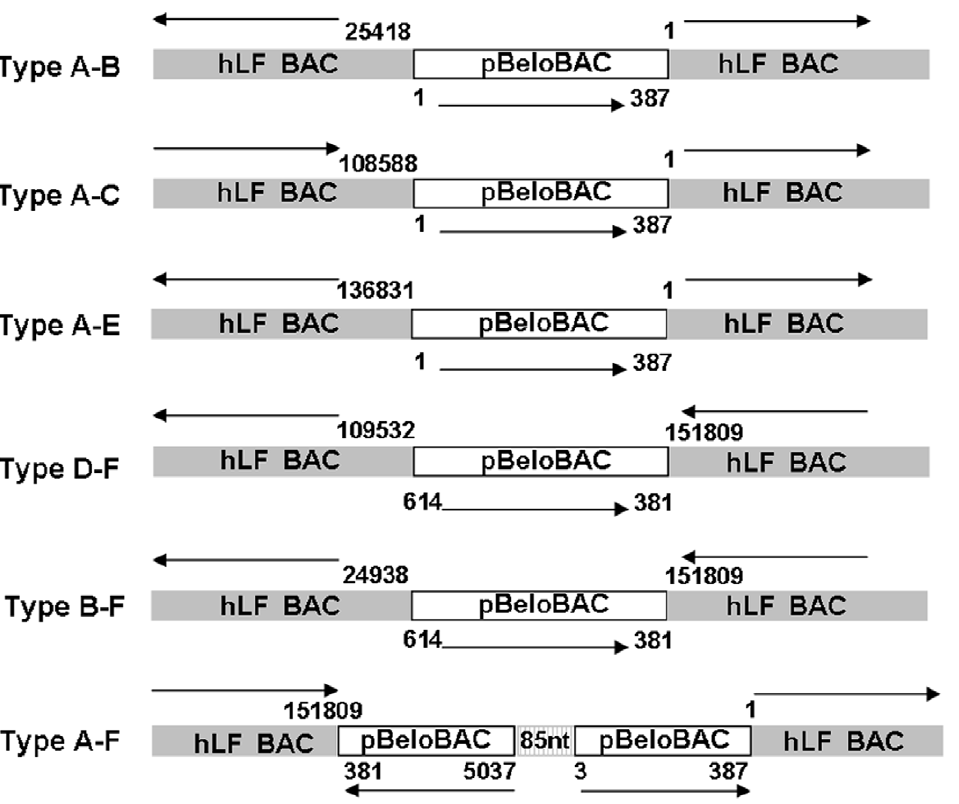
Figure 6. Schematic representation of the BAC rearrangements in transgenes. The positions of the junctions between the hLF BAC fragment (gray box) and the pBeloBAC vector (open box) are indicated, with arrowheads for orientation. An 85-bp unknown sequence was identified in the Type A–F molecule (hatched box). All six of these configurations should have been concatenated in an unknown format at the transgene integration site.